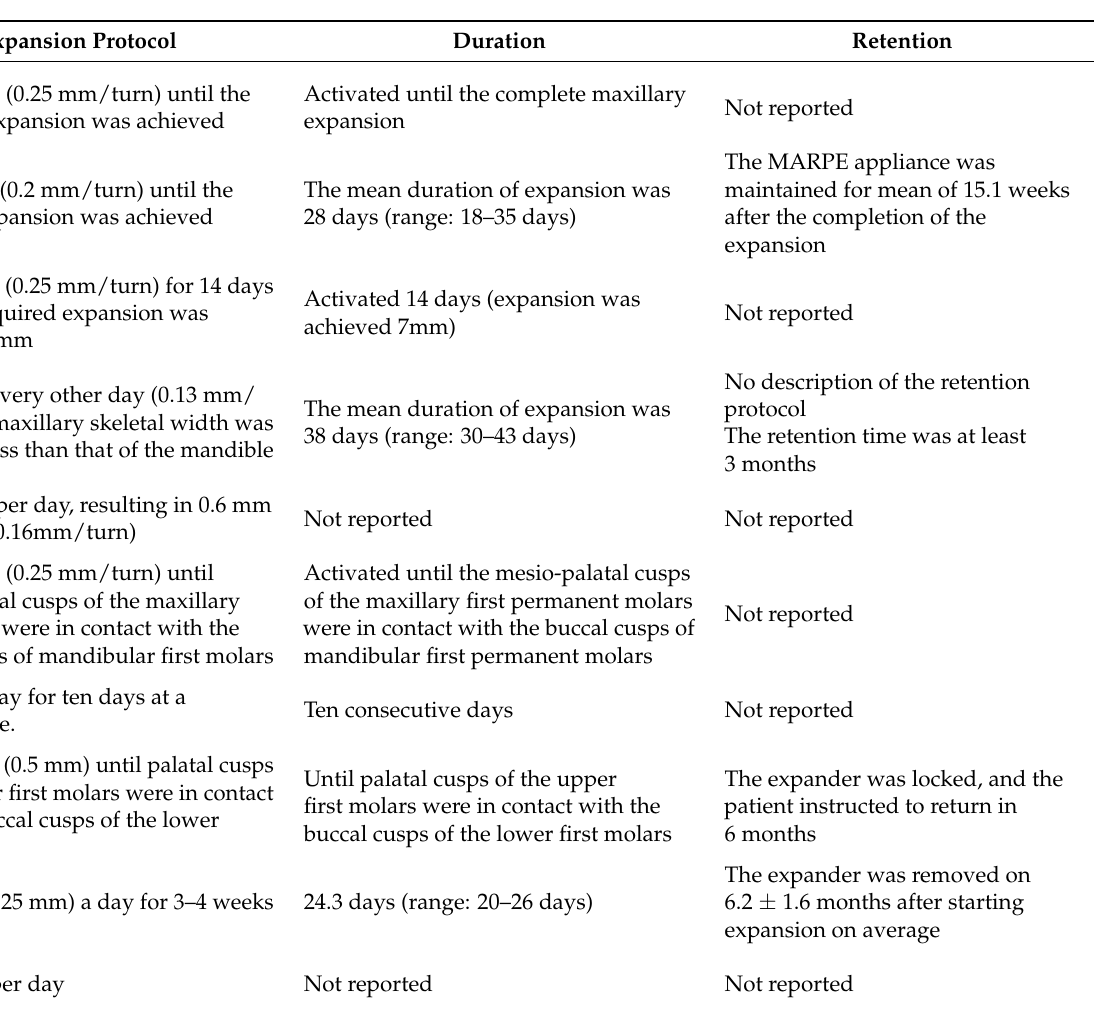
Table 2. Expansion and retention protocols of the included